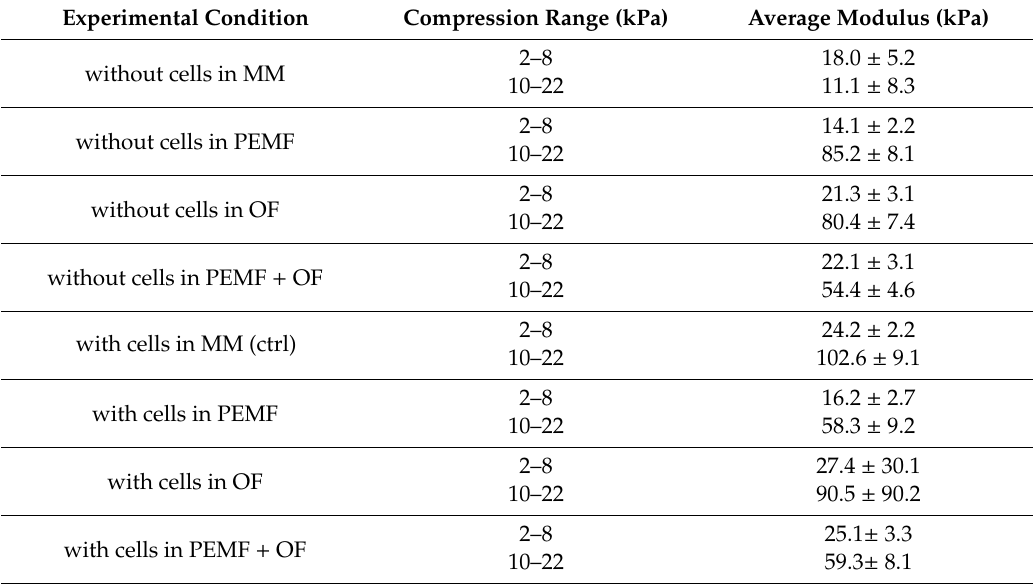
Table 2. Mechanical characterization of wool fibril sponges in the wet state after 21 days in di ff erent culture